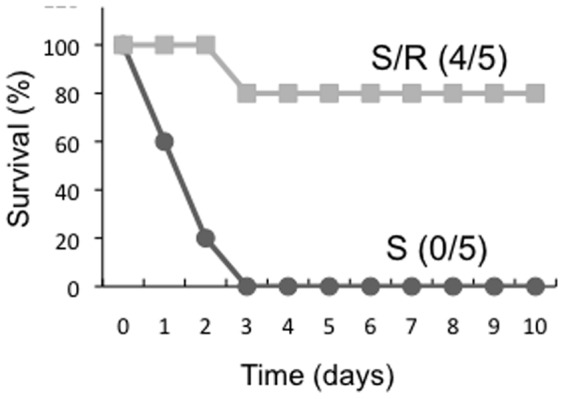
Dietary resveratrol protects mice against a lethal dose of CT.Survival of 8-week-old C57BL/6 mice orally challenged with CT at a dose of 150 µg monitored until day 10 after challenge (n = 5 per group). Representative results from 2 independent experiments with similar results are shown. (S: standard diet-fed mice, S/R: standard diet plus resveratrol-fed mice).